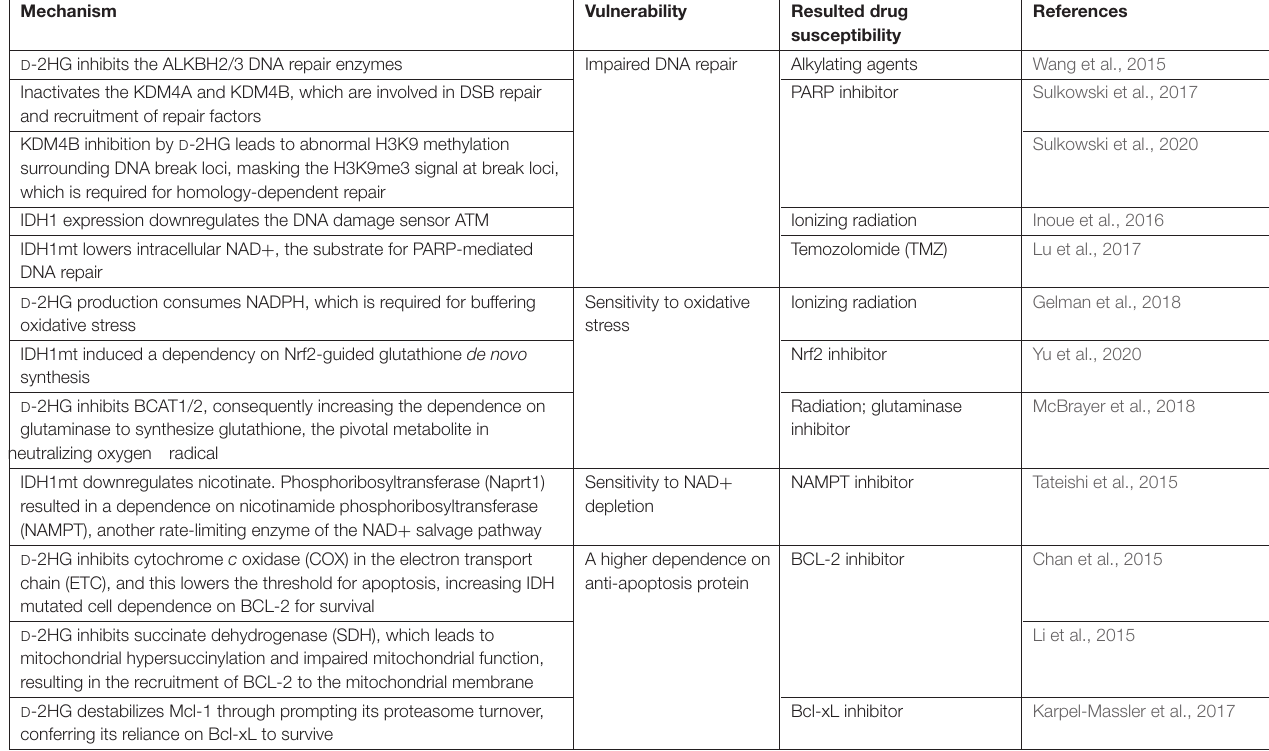
TABLE 1 | The production of D -2HG confers vulnerability to IDHmt